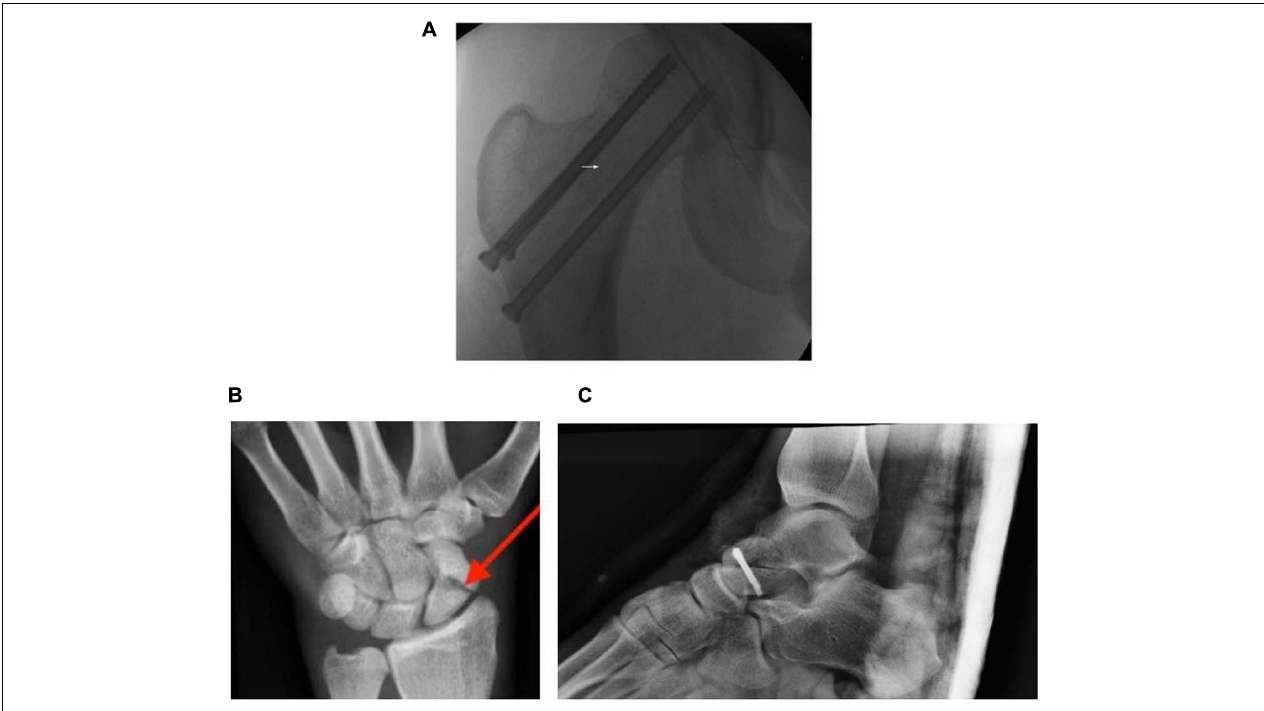
FIGURE 2 | (A) An anteroposterior fluorograph of a displaced femoral neck fracture fixed with cannulated screws. The femoral neck (region around white arrow) connects the femoral head to the rest of the femur. (B) Plain radiograph of the left anteroposterior carpals of a young adult presented with a full thickness scaphoid fracture (red arrow). (C) Post-operative plain radiograph of a talus presented with a fracture. Adapted from Patel (2012), Li et al. (2013), and Kim and Yanuck